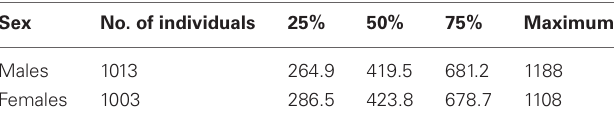
Table 1 | Mean, median, and maximum life span.